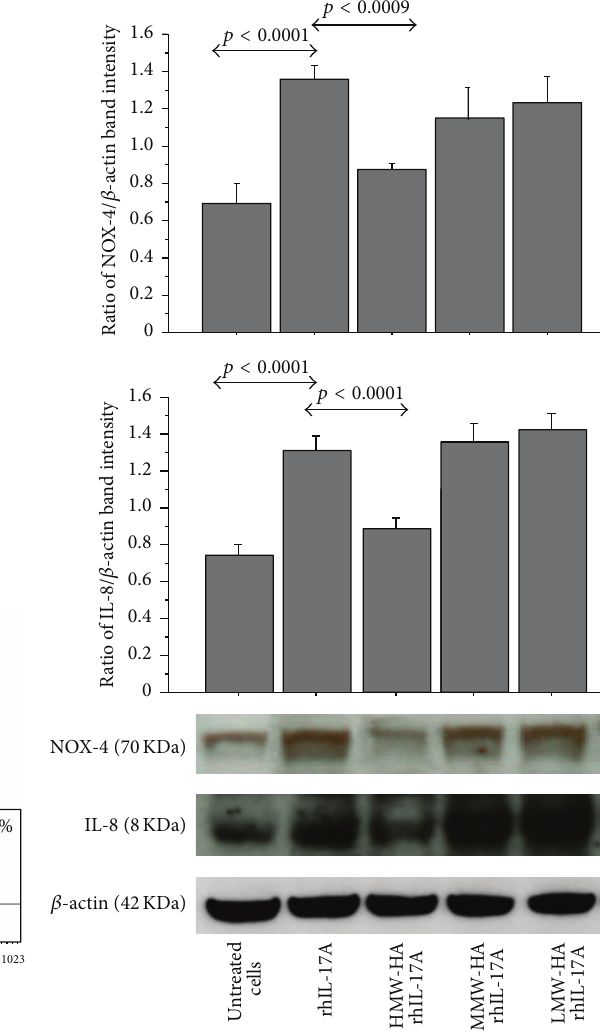
mechanism regulation (Figure 8: graphical